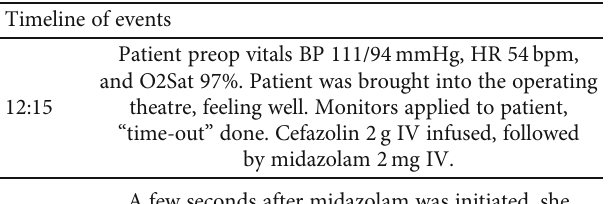
Table 1: Timeline of events relevant to patient ’ s admittance to day surgery and anaphylactic